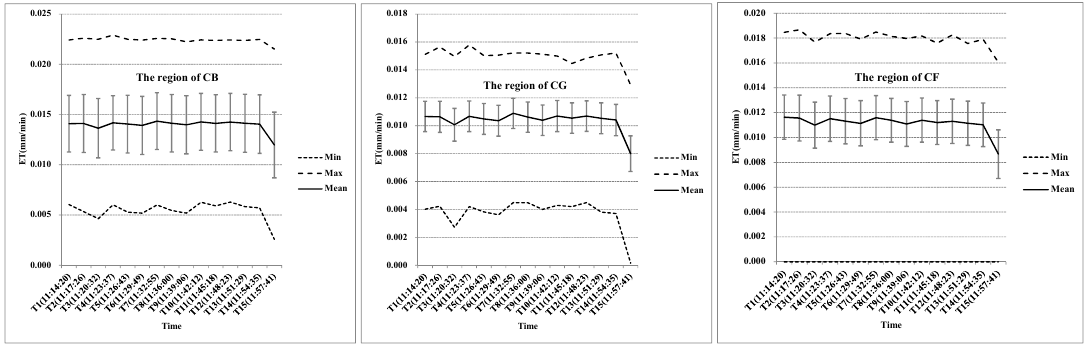
Figure 7. ET of GF-4 at time T 1 –T 15 in areas CB, CG, and CF (the minimum value, the maximum value, the average value, and the standard error).